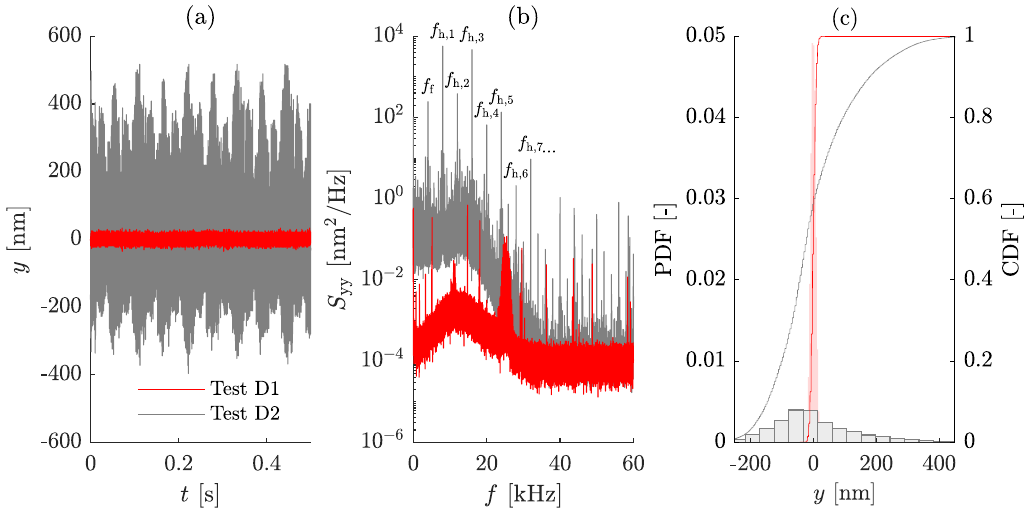
Figure 10. Comparison of cap tests in test device Configurations D1 (benchmark, fully decoupled cap test) and D2 (target coupled to spindle): ( a ) time domain; ( b ) spectral density; and ( c ) probability density and cumulative distribution